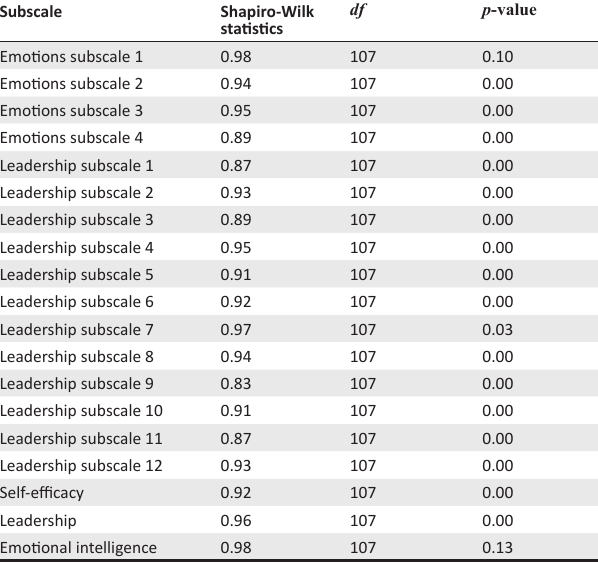
TABLE 7: Shapiro-Wilk’s test of normality for